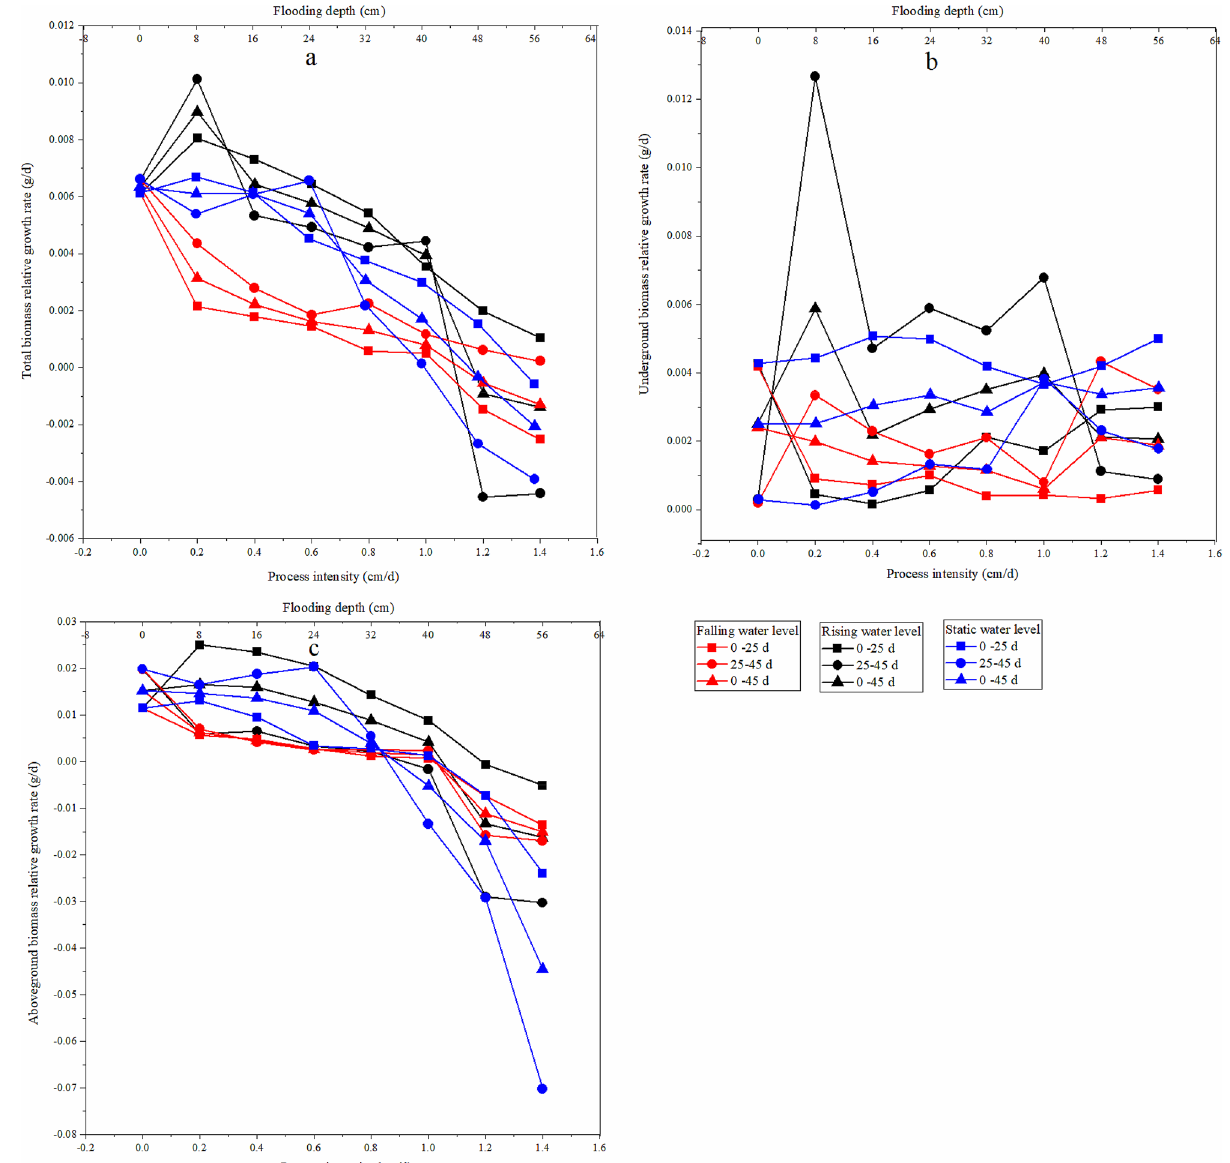
Figure 6. Effect of different hydrological environments on the relative growth rate of the biomass of C. cinerascens. ( a ) Total biomass relative growth rate. ( b) Underground biomass relative rate. ( c) aboveground biomass growth